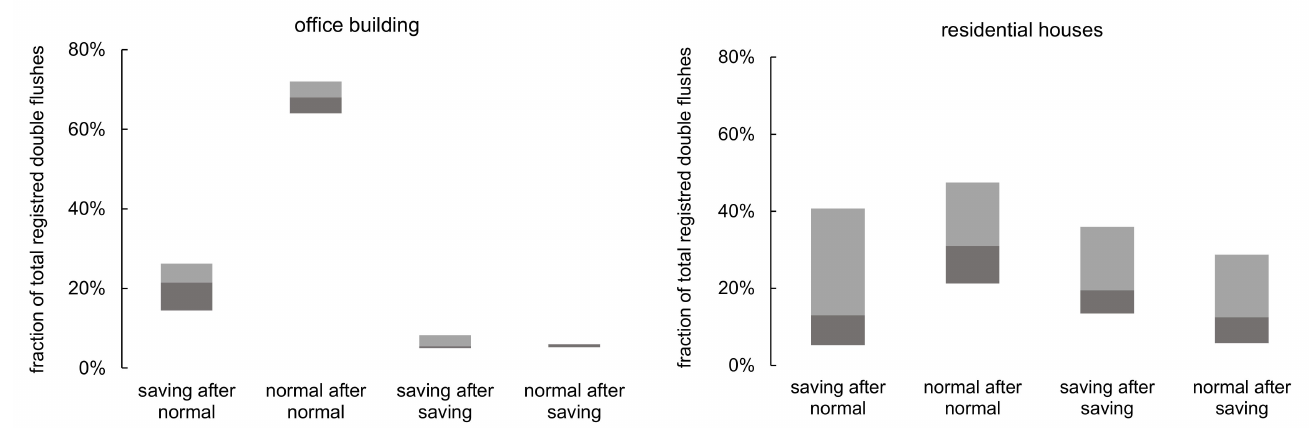
Figure 4. Details on flushing mode (normal, saving) of the identified putative double flushes (defined as a flush occurred upon 180 s to the previous flush at the same toilet) for the office building (right) and residential houses (left). The bars show the variation over respectively, with the intervals between median and first and third quartile.